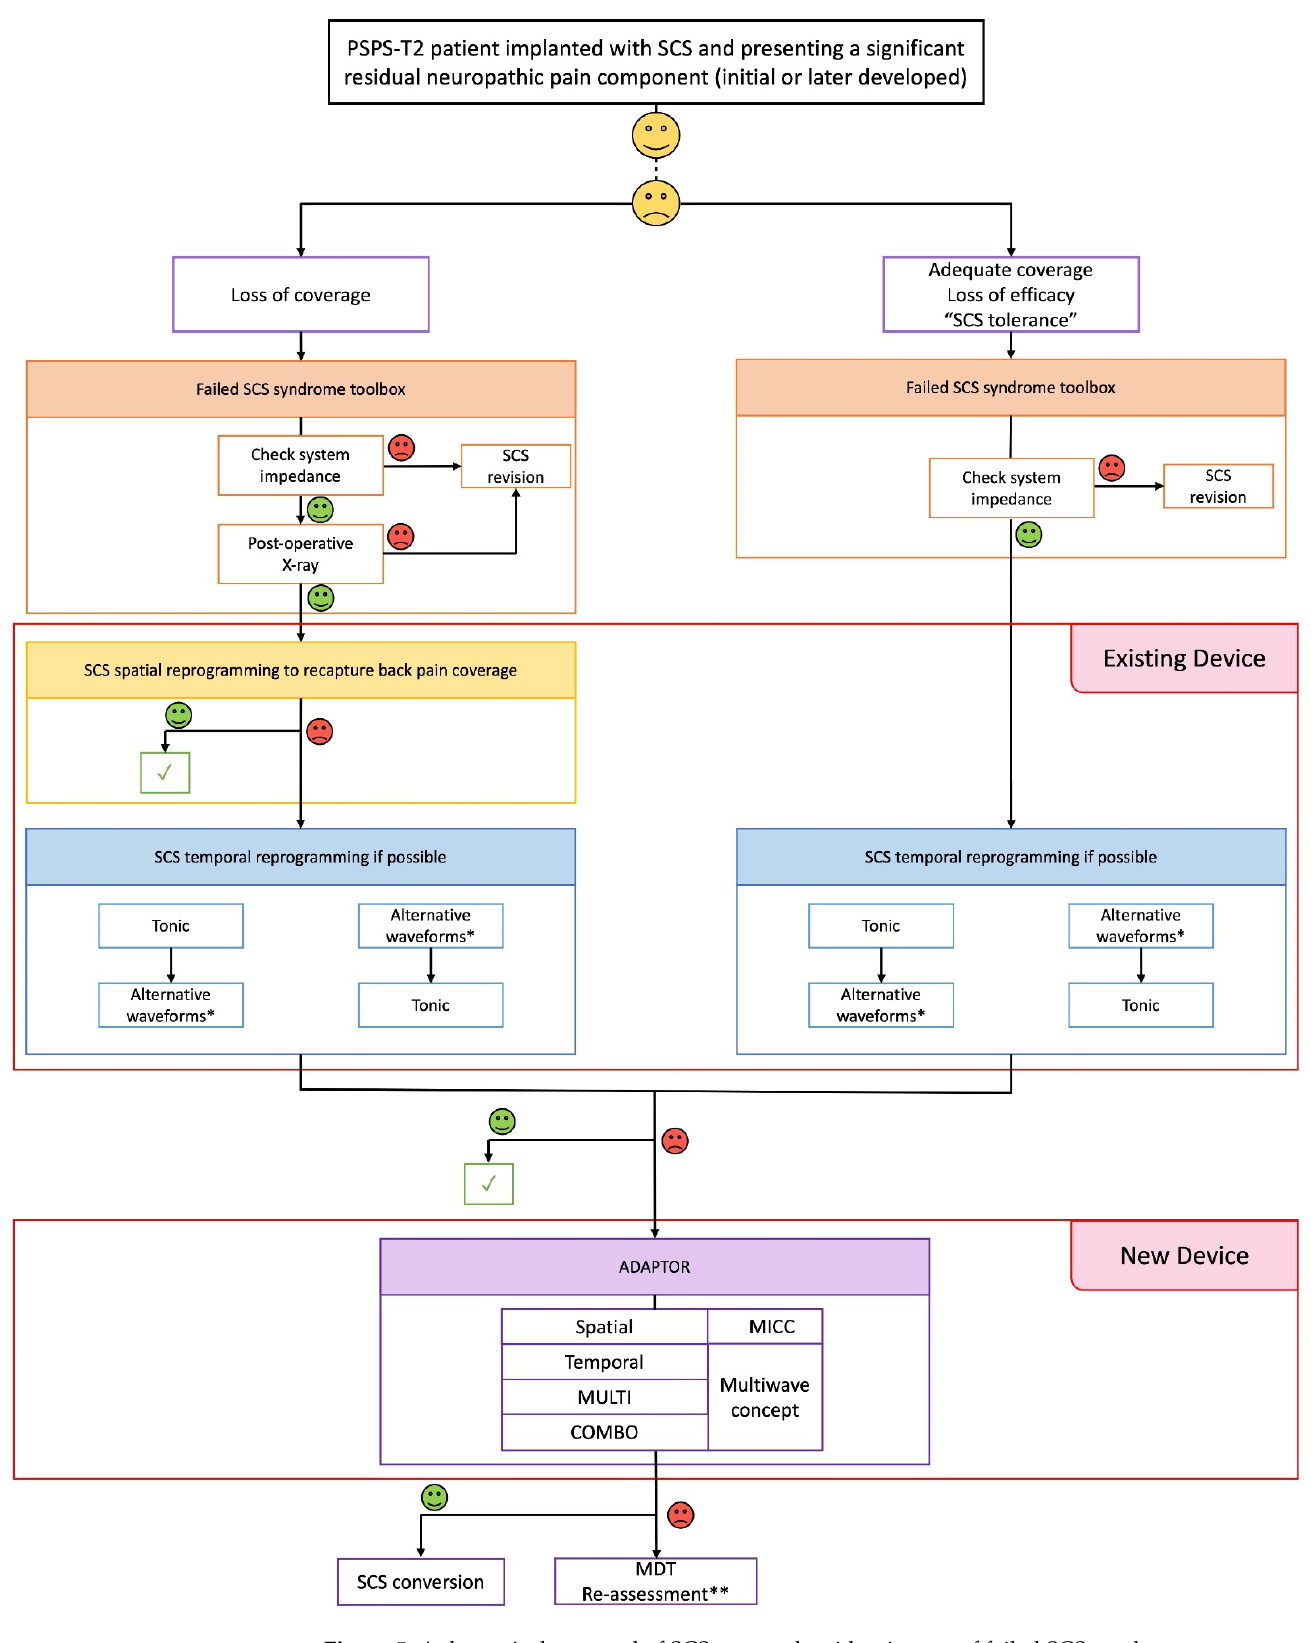
Figure 5. A theoretical proposal of SCS rescue algorithm in case of failed SCS syndrome.